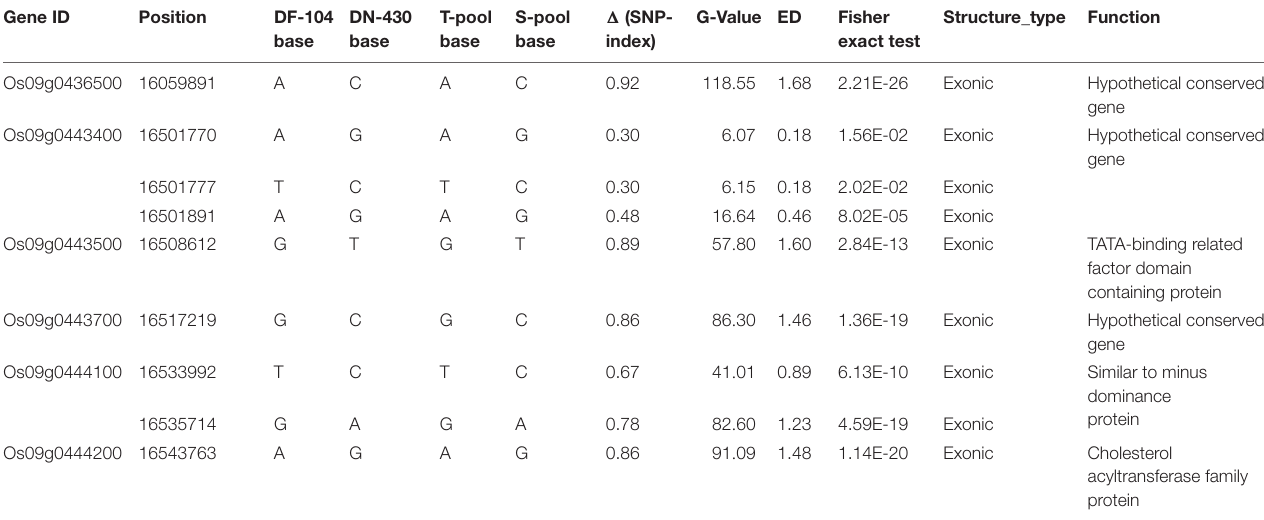
TABLE 3 | Identification of SNPs in putative candidate genes for CTBB. Gene